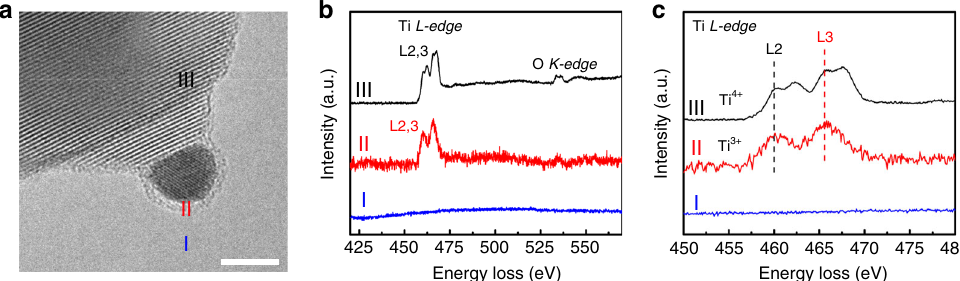
Fig. 2 Electron Energy Loss Spectroscopy analysis. a HRTEM image of Au/TiO 2 @M-N-800. b and c Fitted EELS spectra from 450 to 480 eV. The spectra were background-subtracted. The scale bar corresponds to 5 nm. Additional EELS results can be found in Supplementary Figs. 6 – 8.